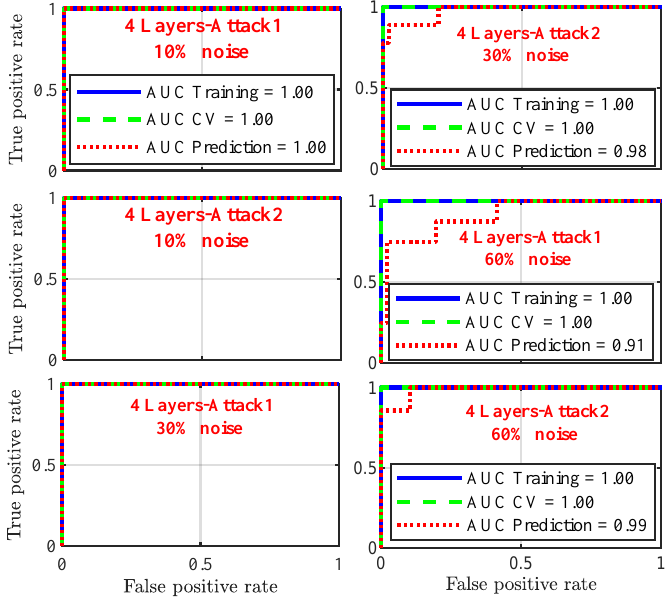
Figure 10. The ROC of various attack scenarios considering measurements noise